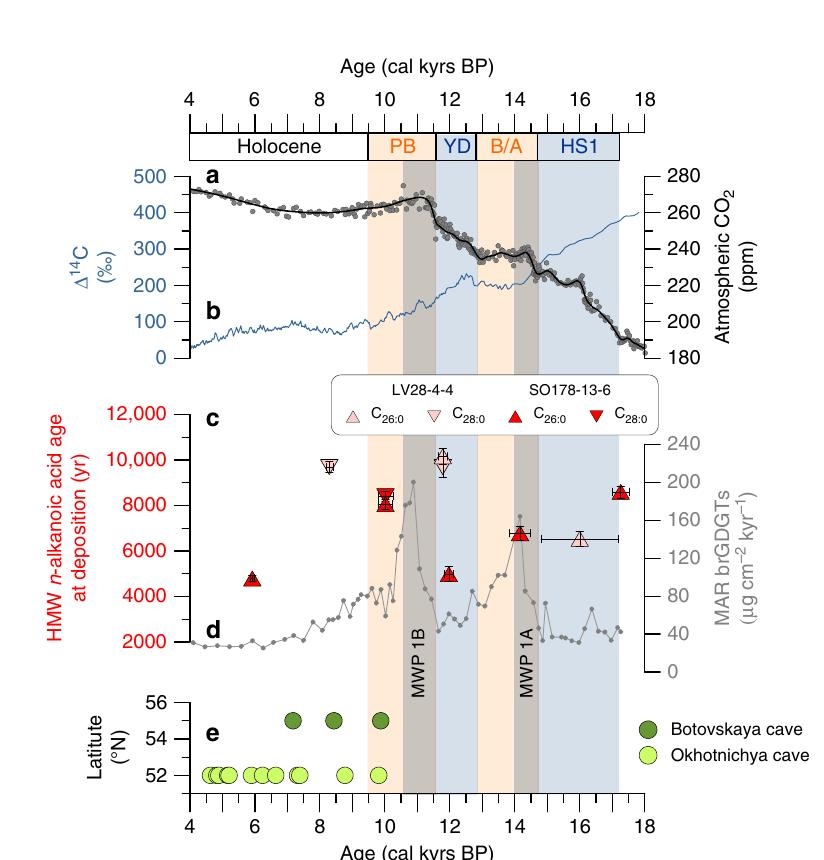
Fig. 3 Proxies used to reconstruct permafrost dynamics and carbon mobilization. a Atmospheric CO 2 mixing ratio from ice cores 12, 13 (data as in ref. 69 ); b atmospheric Δ 14 C ( ‰ ) as reconstructed in IntCAL13 11 ; c age at deposition of higher plant derived C 26:0 and C 28:0 n -alkanoic acids from SO178-13-6 (red triangles) and LV28-4-4 (pink triangles) derived from compound-speci fi c radiocarbon dates of the respective biomarkers with horizontal error bars representing 2 σ age uncertainties of the closest age control point (see Fig. 2) and vertical error bars representing the propagated age uncertainties after blank correction (see Methods), please note that the age scale goes from 4 to 18 kyrs BP here and that additional ages of n -alkanoic acids deposited before 4 kyrs BP can be found in Table 1; d mass accumulation rates (MAR) of branched glycerol dialkyl glycerol tetraethers (brGDGTs) of core SO178-13-6 representative of MAR of all terrigenous biomarkers; e periods of vadose speleothem growth linked to permafrost thaw and/or absence at the Botovskaya cave and the Okhotnichya cave 9 . Orange boxes highlight the warm phases Bølling-Allerød (B/A) and Pre-Boreal (PB), the Younger Dryas cold spell (YD) and Heinrich Stadial 1 (HS1) are marked in blue; grey boxes mark the periods of melt water pulse 1a (MWP-1A) and the putative